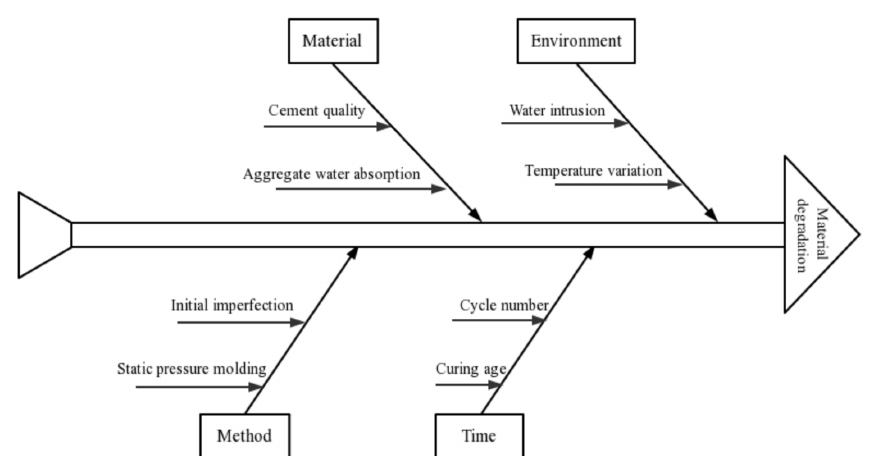
Figure 1. Research flow diagram.